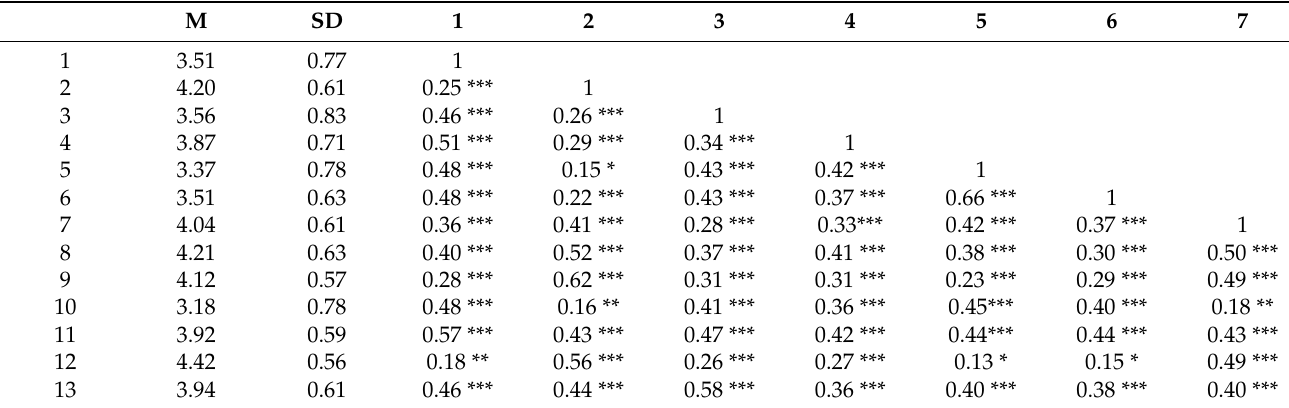
Table 6. Correlations among the sub-factors in effort, reward and self-management.